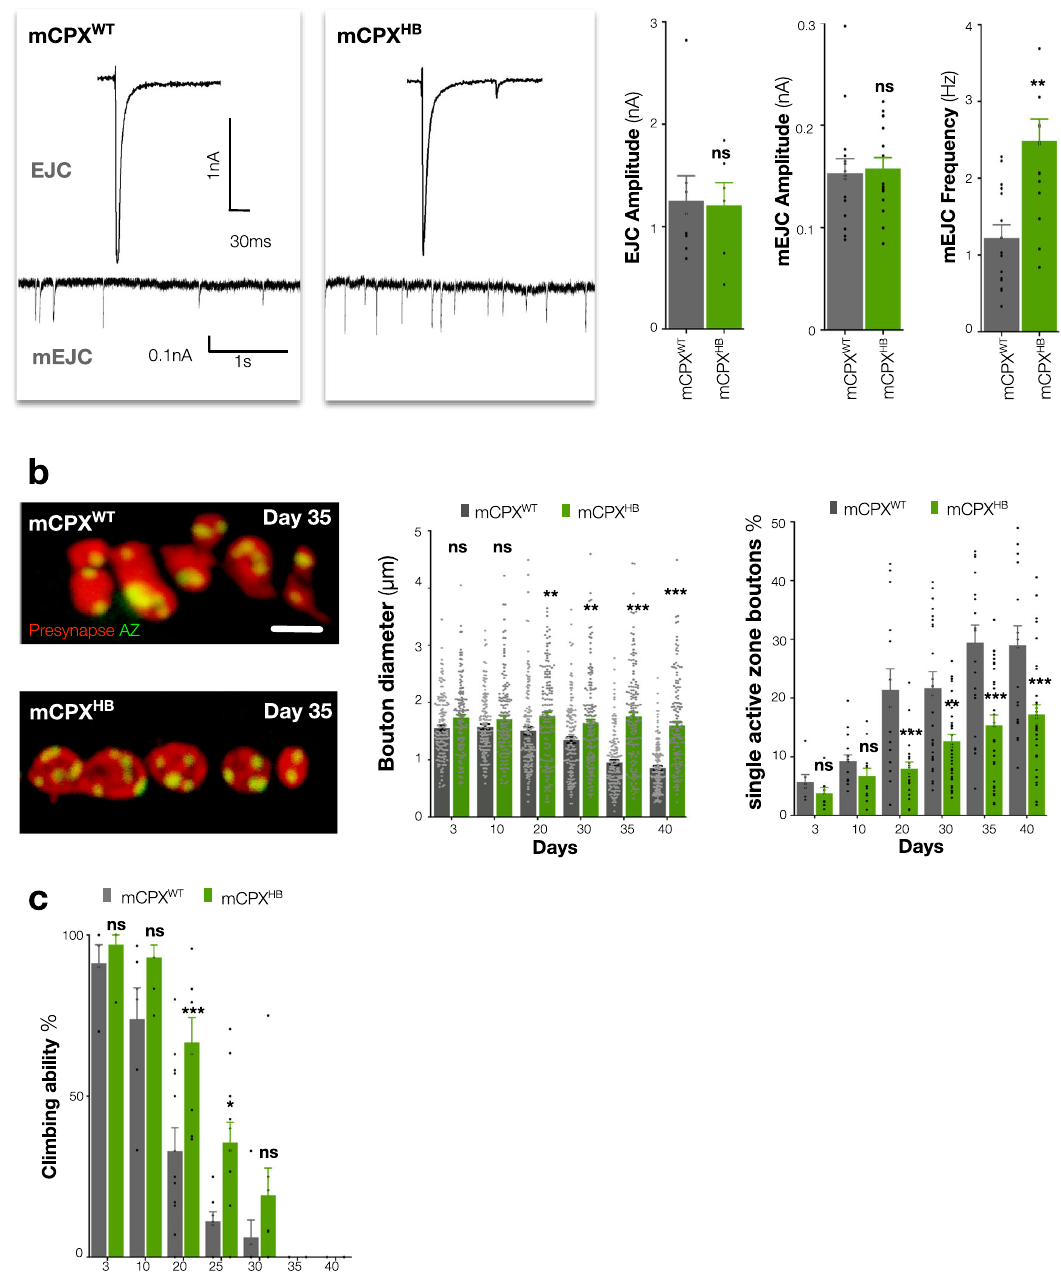
Fig. 4 Increasing miniature neurotransmission preserves synapses and prolongs motor ability during ageing. a Representative EJC (above) and mEJC (below) traces, quanti fi cation of EJC amplitude, mEJC amplitude and frequency of HB9 neuron selective adult conditional murine Cpx rescued wild type (mCpx WT ) [UAS> Cpx RNAi /UAS > GFP; HB9 > Gal4, TubGal80 ts / cpx SH1 , UAS> mCpx WT ] and mCpx ‘ Helix Breaker ’ (mCpx HB ) [UAS> Cpx RNAi /UAS > GFP; HB9 > Gal4, Tub > Gal80 ts / cpx SH1 , UAS> mCpx HB ] mutants at 20 days after eclosion. b Representative images of presynaptic HB9 neuron boutons (red, GFP) and active zones (Brp, green), quanti fi cation of bouton diameters and percentage of boutons with only a single active zone (bouton fragmentation) of mCpx WT and mCpx HB mutants until 40 days after eclosion. Images at same magni fi cation. c Quanti fi cation of the climbing ability of motor neuron selective adult conditional mCpx wild-type mCpx WT [UAS > Cpx RNAi /OK6 > Gal4, UAS > GFP; Tub>Gal80 ts /cpx SH1 , UAS> mCpx WT ] and mCpx HB [UAS > Cpx RNAi /OK6 > Gal4, UAS > GFP; Tub > Gal80 ts /cpx SH1 , UAS > mCpx HB ]. Unpaired two-tailed t -test, p = 0.89, n ≥ 6 presynaptic terminals per timepoint ( a , EJC amplitude), p = 0.81, n ≥ 15 presynaptic terminals per timepoint ( a , mEJC amplitude), *** p < 0.003, n ≥ 15 presynaptic terminals per timepoint ( a , mEJC frequency). Two-way ANOVA, followed by Sidak ’ s multiple comparison tests were used to compare the mean of control and experimental genotypes in that timepoint, ns not signi fi cant, *** p ≤ 0.001, n ≥ 149 boutons per timepoint ( b , bouton diameters), ns not signi fi cant, ** p < 0.002, *** p < 0.001, n ≥ 7 presynaptic terminals per timepoint ( b , single active zone boutons), ns not signi fi cant, * p < 0.033, *** p < 0.001, n ≥ 4 groups per timepoint ( c ). All statistical analysis details with a precise value of ‘ n ’ are reported in Supplementary Tables 4 and 6 and in Source Data fi le. Scale bar = 2 μ m ( b ). Experiments were carried out at 29 °C. Data are represented as mean ± SEM. n = biologically independent samples.